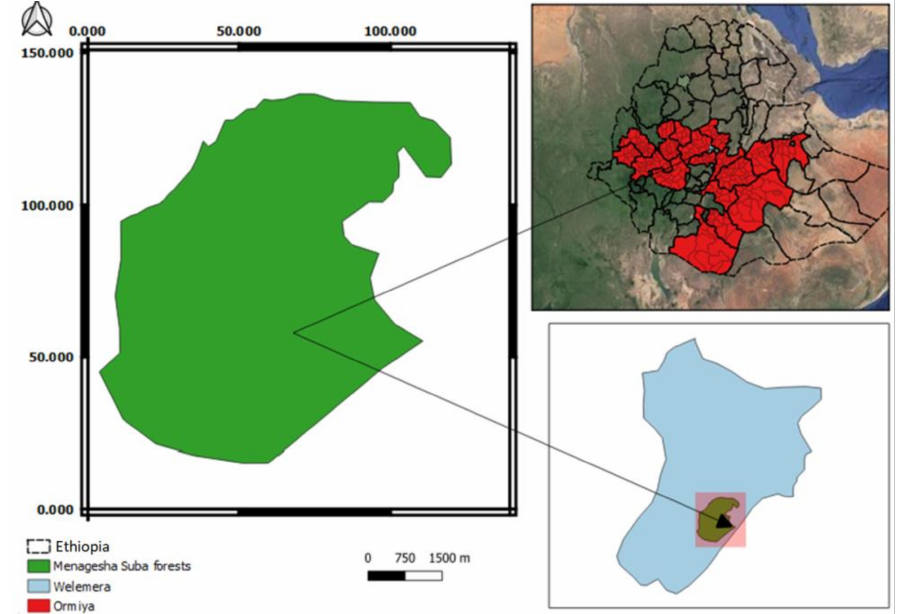
Figure 1. Location map of the study area, Menagesha Suba, central Showa, Oromia National Regional State,